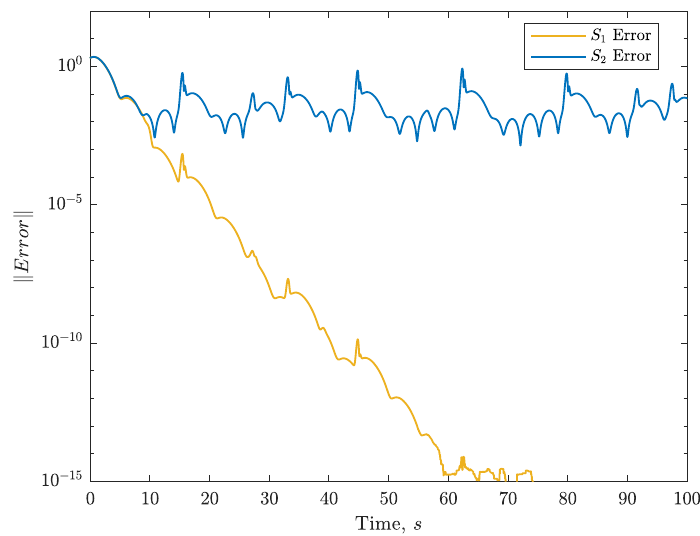
Figure 5. Normalized synchronization errors at receiver systems during a symbol transmission associated with value S 1 at the